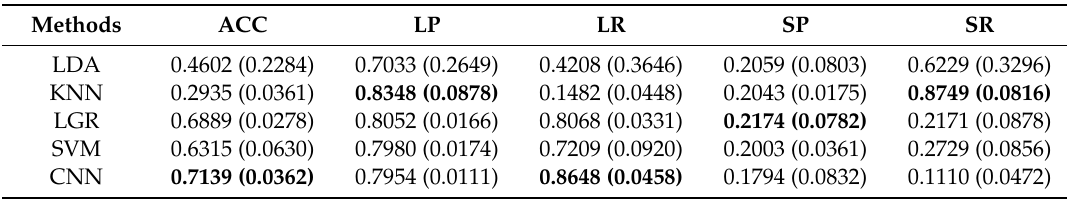
Table 4. Performance of the methods in FNC classification.